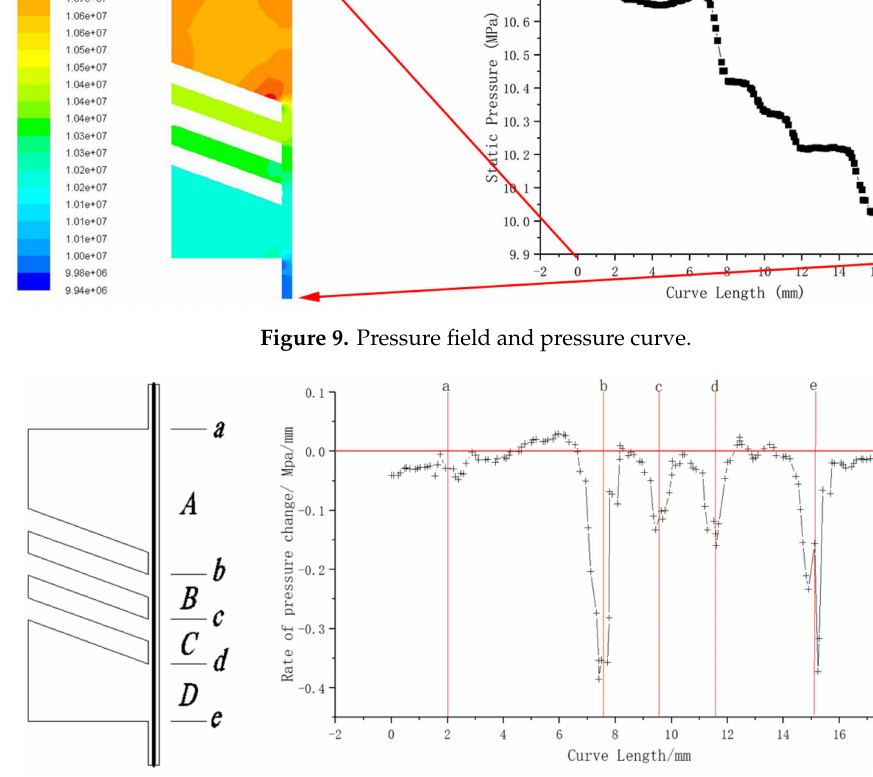
Figure 10. Curve of the pressure change rate.